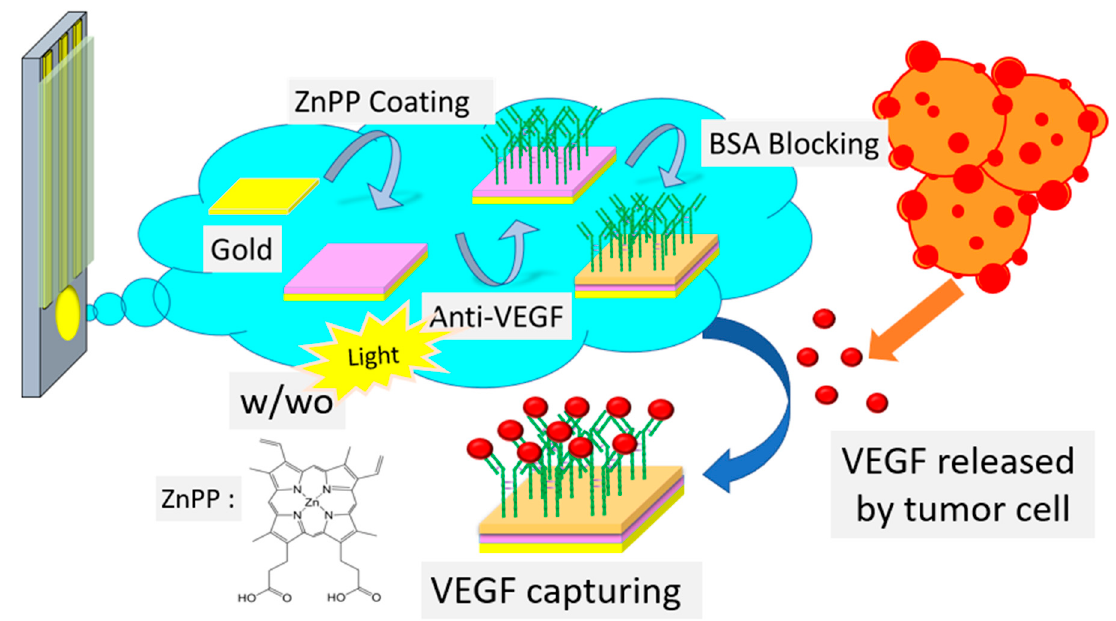
Figure 1. Schematic of Au/ZnPP/Avastin/bovine serum protein (BSA) with or without light treatment (w/LT and w/o LT) electrode preparation process.